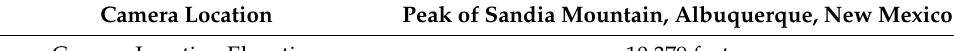
Table 2. Experiment Location.